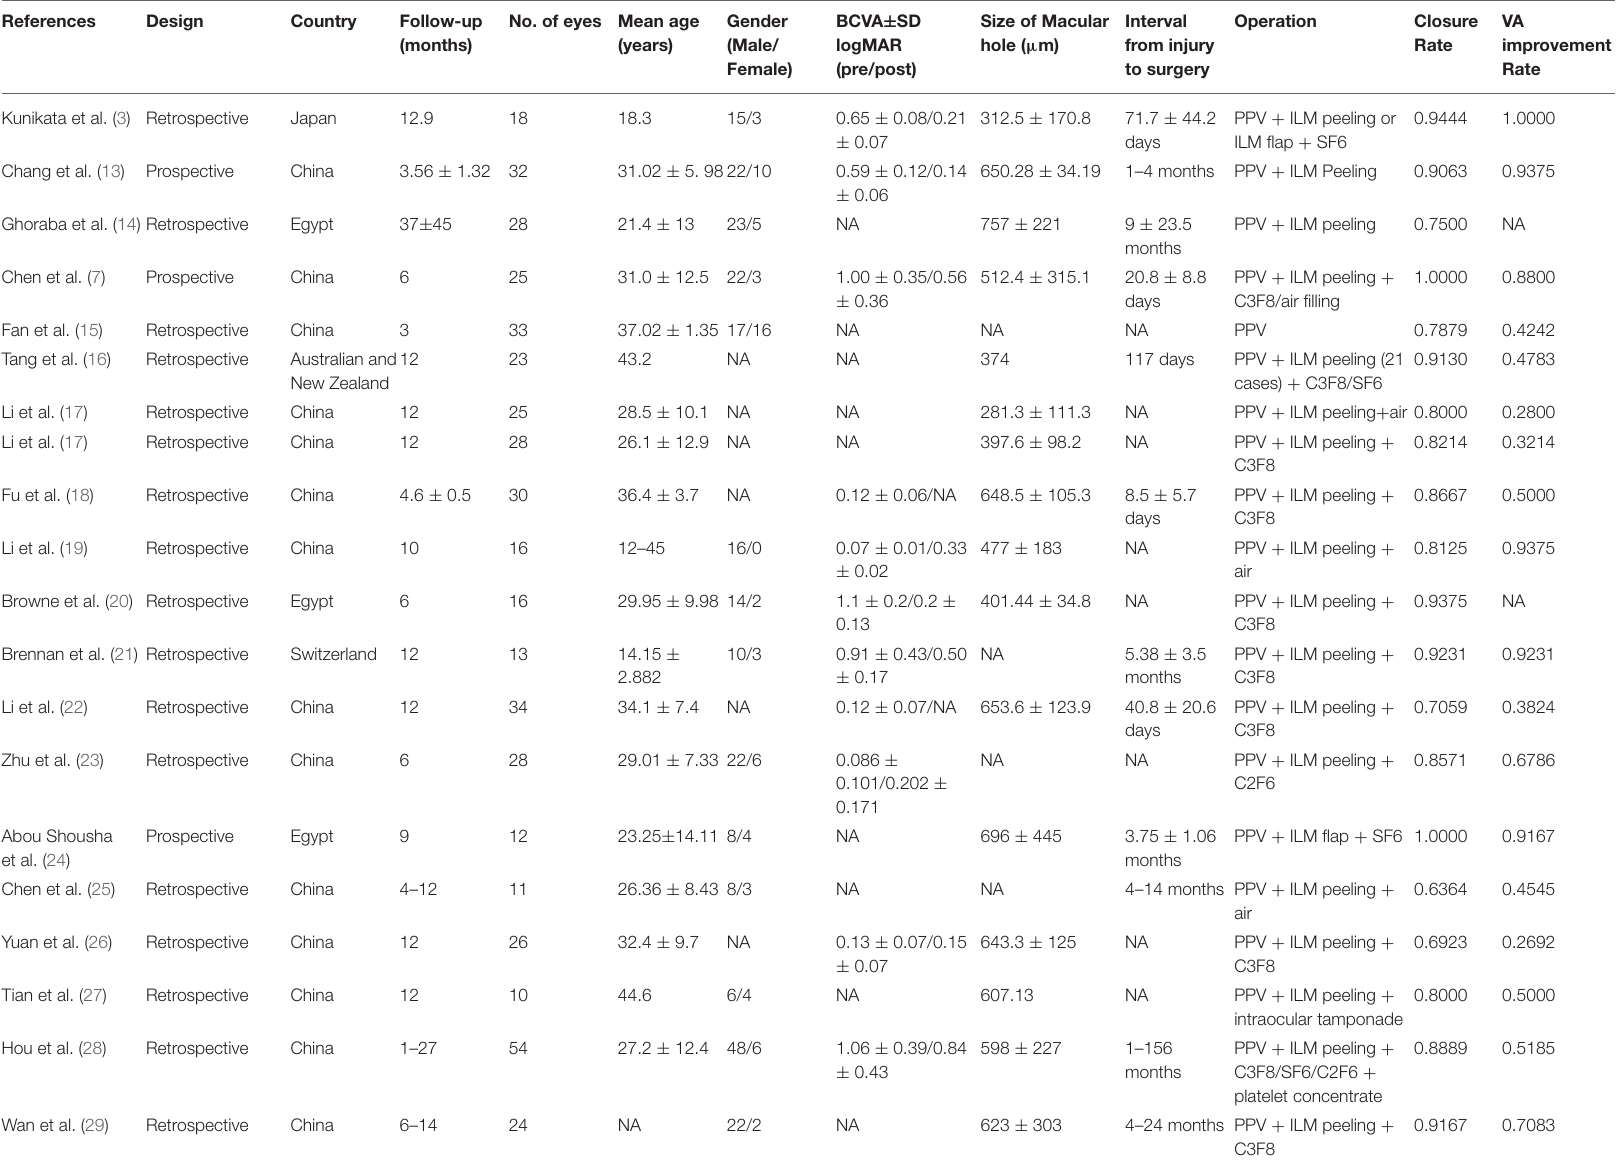
TABLE 1 | Study design and baseline patient characteristics of the surgery group